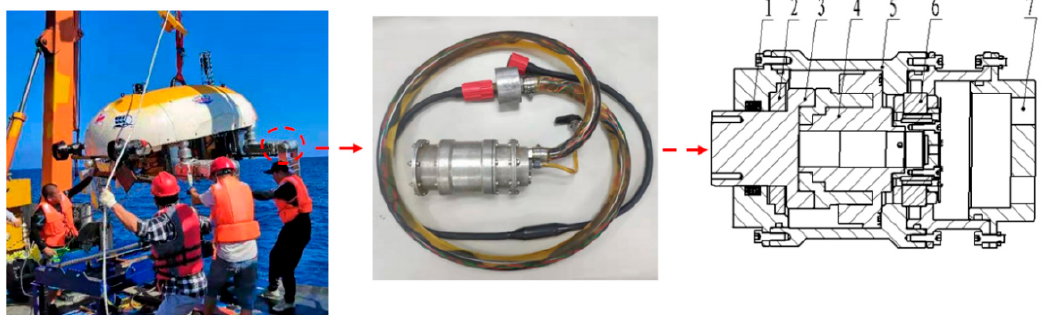
Figure 1. Structure of a deep-sea electric oil-filled joint actuator. 1—sealing assembly; 2—angular position sensor; 3—output shaft; 4—gear reducer; 5—housing; 6—motor; 7—pressure compensation